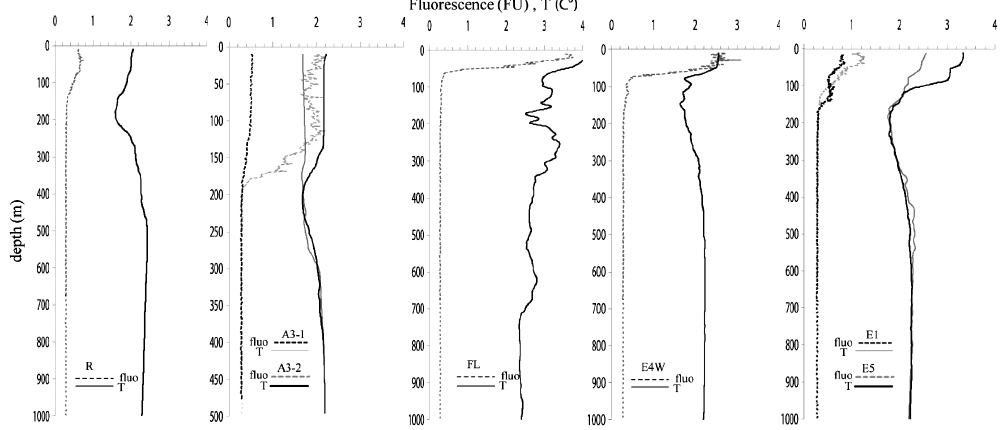
Figure 2. Profiles of temperature and Chl a as derived from in vivo fluorescence for the reference HNLC station (R-2); A3 (first and second visit), F-L, E-4W; and E stations first (E-1), and last visit (E-5). Table 3. Bulk abundances and relative contributions of cytometrically identified subpopulations of virus-like particles (VLPs), heterotrophic bacteria (HB) and heterotrophic nanoflagellates (HNF). Mean values ± SD of three depth layers for the iron-fertilized sites (Fe) and the HNLC site (R-2) are given. %GF: percent high and low green fluorescence VLPs; %HNA and %LNA: percent high and low DNA containing HB. HNF-1, -2, -3 populations were discriminated by flow cytometry and sized by epifluorescence microscopy after cell-sorting in each cytometric group (see also Fig. S1). ML: mixed layer; Z ML : depth of the mixed layer; Z ML –200: bottom of the mixed layer to 200m; >200m: below 200m to the bottom of each station. Asterisks indicate significant differences between iron-fertilized sites and station R-2 (Mann–Whitney *: p <0.05, **: p <0.001 ***: p